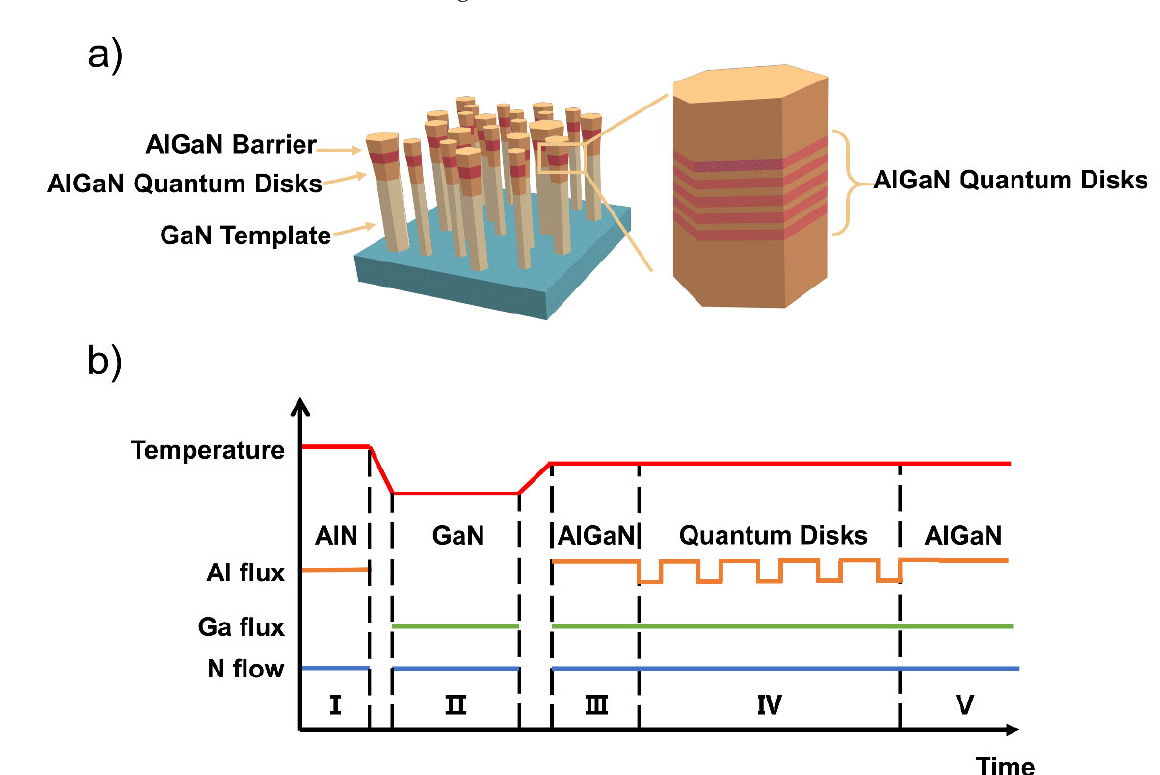
Figure 1. ( a ) The schematic of the AlGaN Qdisk nanorods; ( b ) the schematic diagram of the growth process.